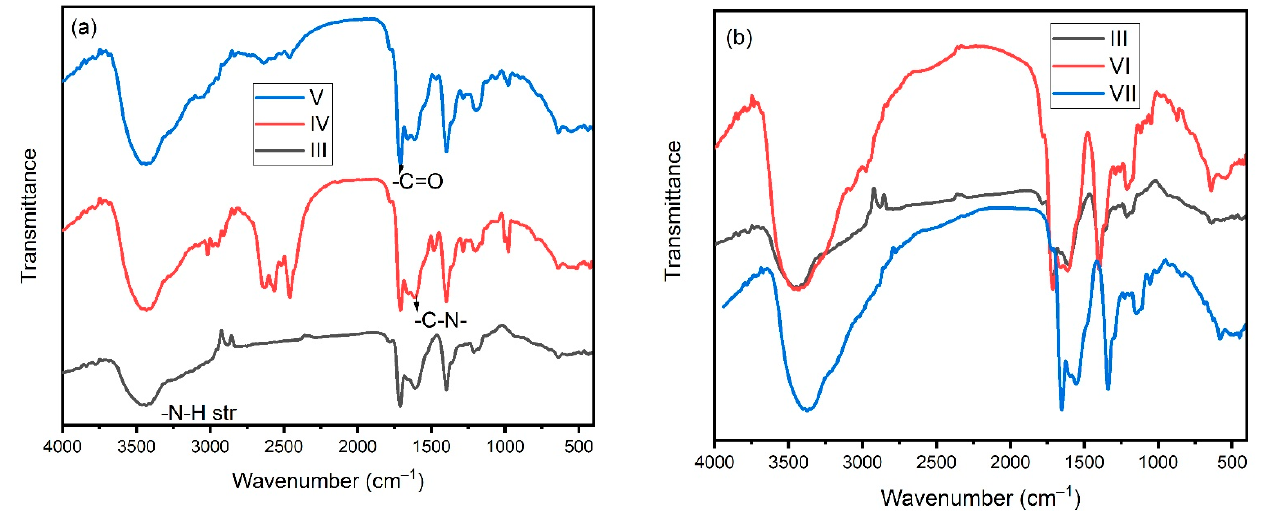
Figure 1. FTIR spectra of polymers ( a ) III, IV and V; and ( b ) III, VI and VII.